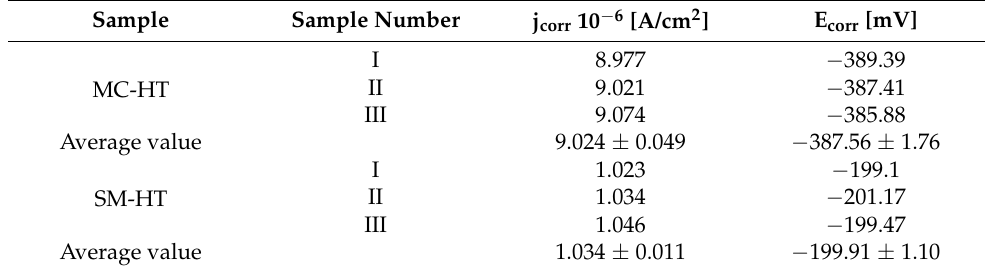
Table 5. Values of j corr and E corr from electrochemical examination.